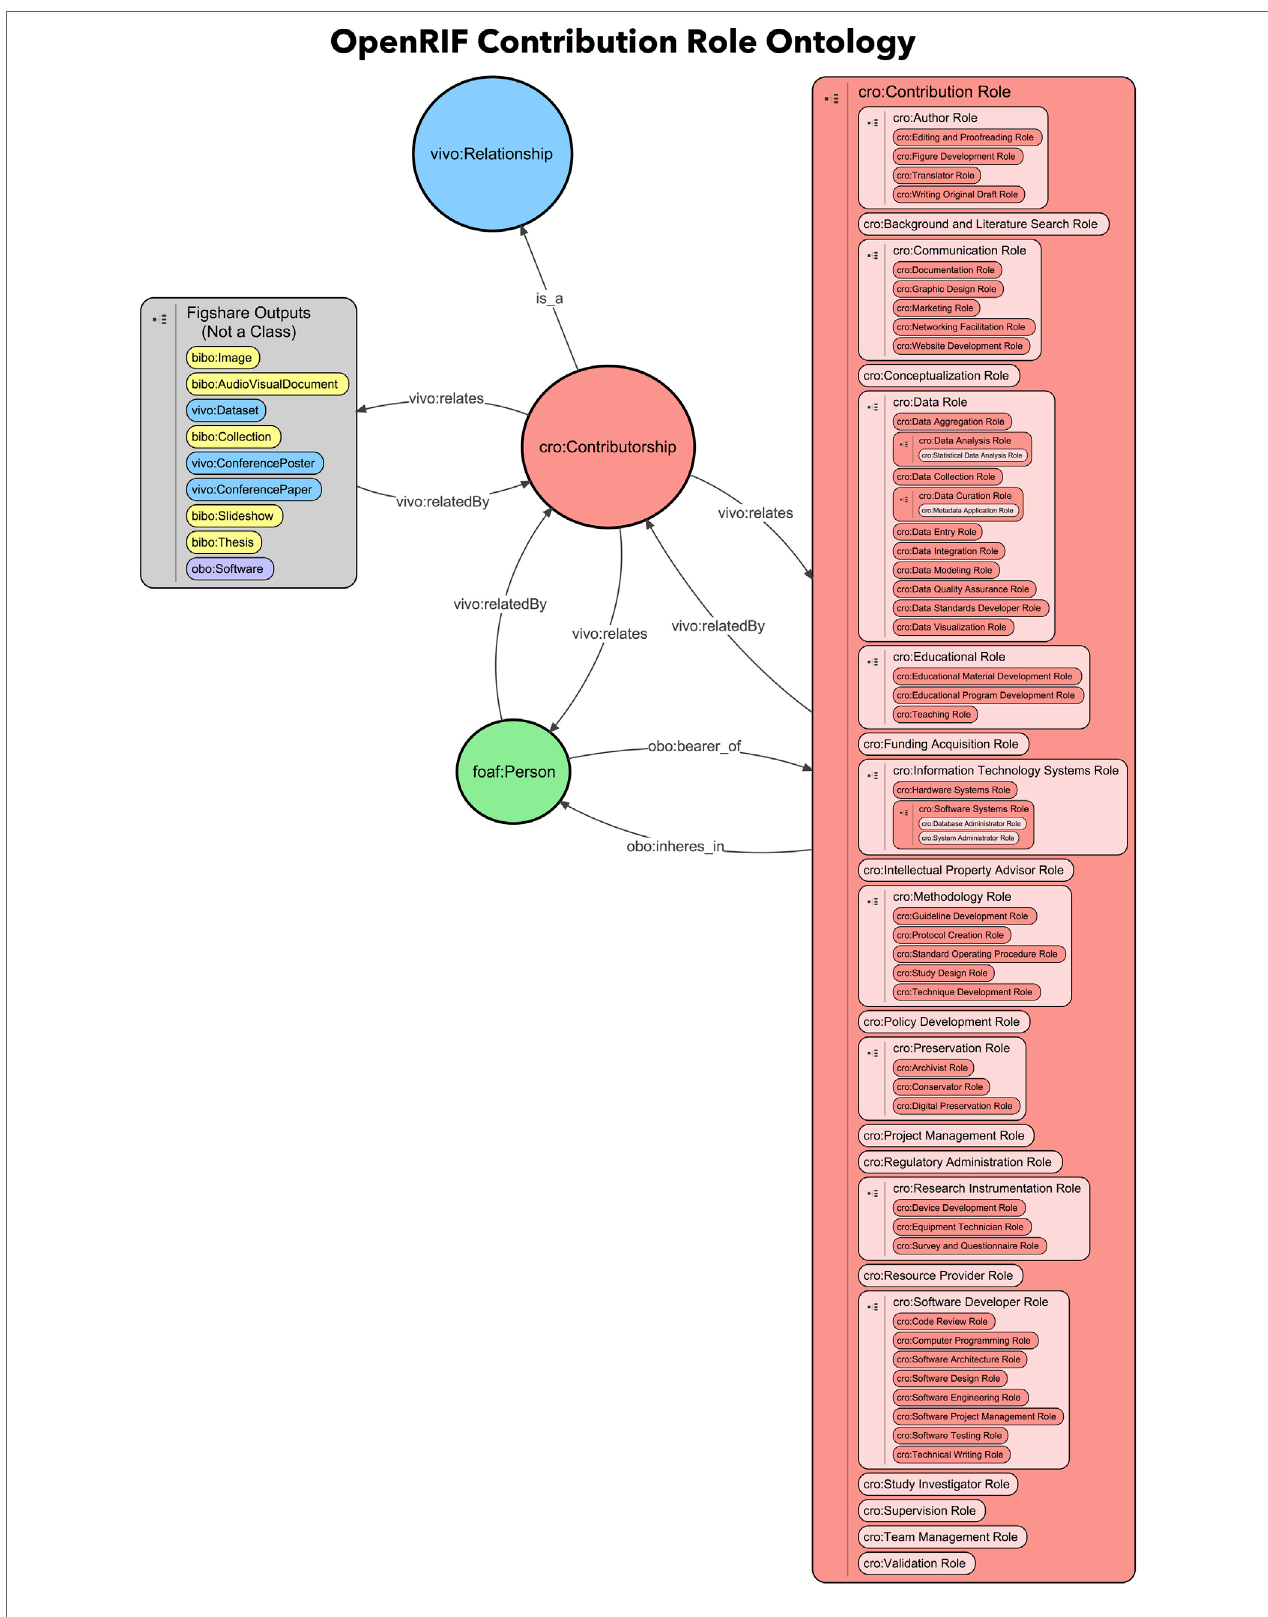
FIguRe 6 | Contribution role